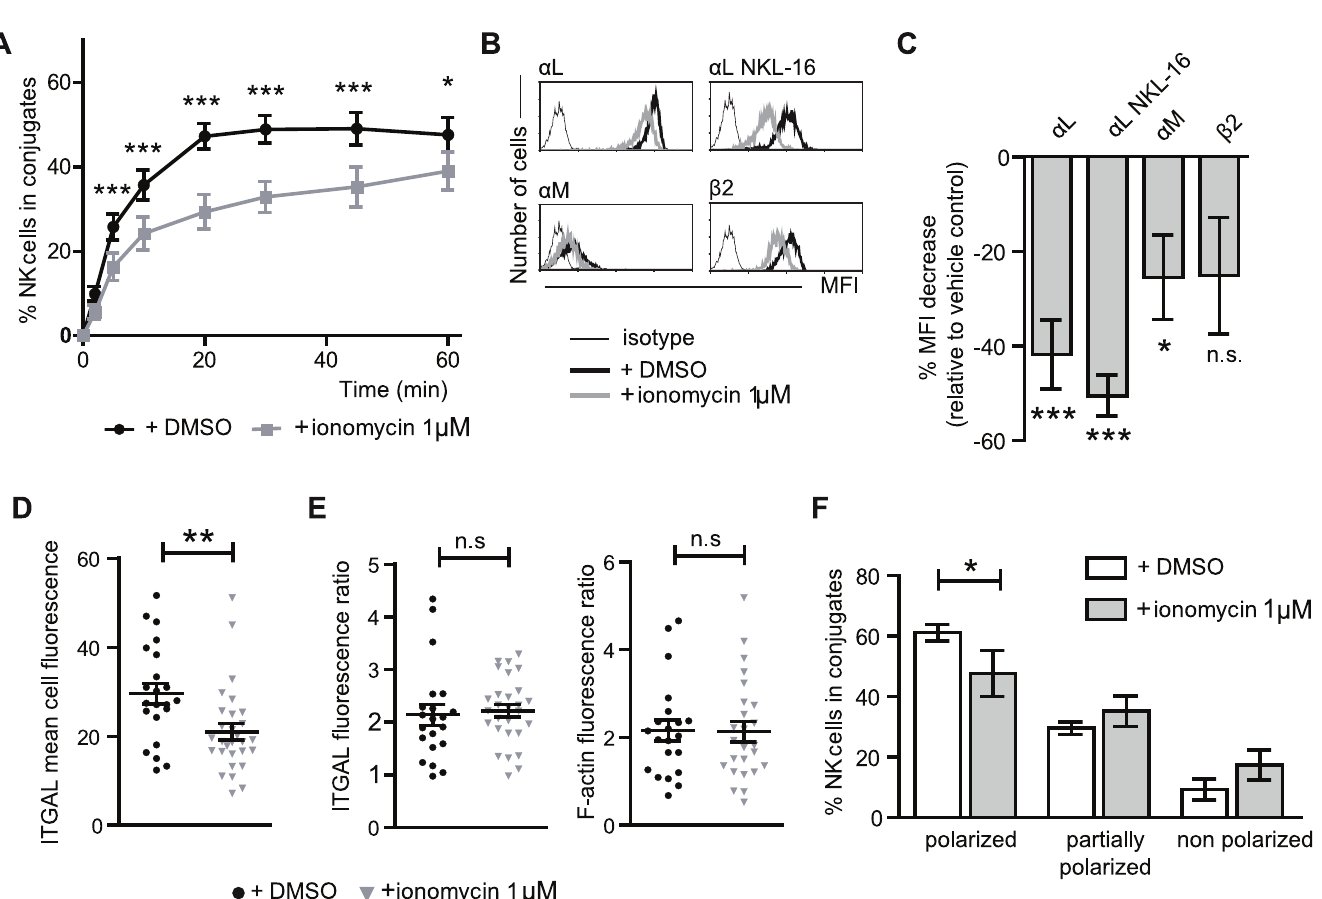
Fig 4. Ionomycin treated NK cells form fewer conjugates with target cells, and express lower levels of integrin molecules. However, those cells that form conjugates are able to polarize α L, lytic granules and accumulate F-actin in the immune synapse with target cells as efficiently as control cells. ( A ) NK cells and target cells were stained with different color dyes and the double positive events, viewed by flow cytometry, used to calculate the percentage of NK cells forming conjugates over time ( n = 15 ). ( B ) Representative flow cytometry histograms of close and open α L, α M and β 2 integrin subunits expression by flow cytometry. ( C ) Relative decrease of the MFI expression measured by flow cytometry of the different integrin molecules relative to the expression on control cells ( average values of at least 10 experiments ). Two tailed paired Student´s T test analysis of the logarithm of raw data. ( D ) Mean fluorescence intensity of LFA-1 staining in NK cells (confocal microscopy images quantitated using Image J ( n = 22 DMSO, n = 29 ionomycin). Mann Whitney test. ( E ) Those ionomycin-treated NK cells that form conjugates with target cells are able to polarize α L and accumulate F-actin in the immune synapse. The ratios of α L and F-actin fluorescence between the synapse, and non-synapse membrane zones of control and ionomycin treated NK cells were quantified using ImageJ-FIJI (data from three independent experiments. n = 22 DMSO, n = 29 ionomycin). Mann Whitney test. ( F ) Lytic granules polarization on NK cells that formed conjugates by confocal microscopy was stratified in polarized, partially-polarized and non-polarized visually (data from four independent experiments. n = 249 DMSO, n = 97 ionomycin). Paired two way ANOVA analysis and Bonferroni posttest. The data show mean ± SEM. * p < 0.05, ** p < 0.01, *** p < 0.001, n . s .: